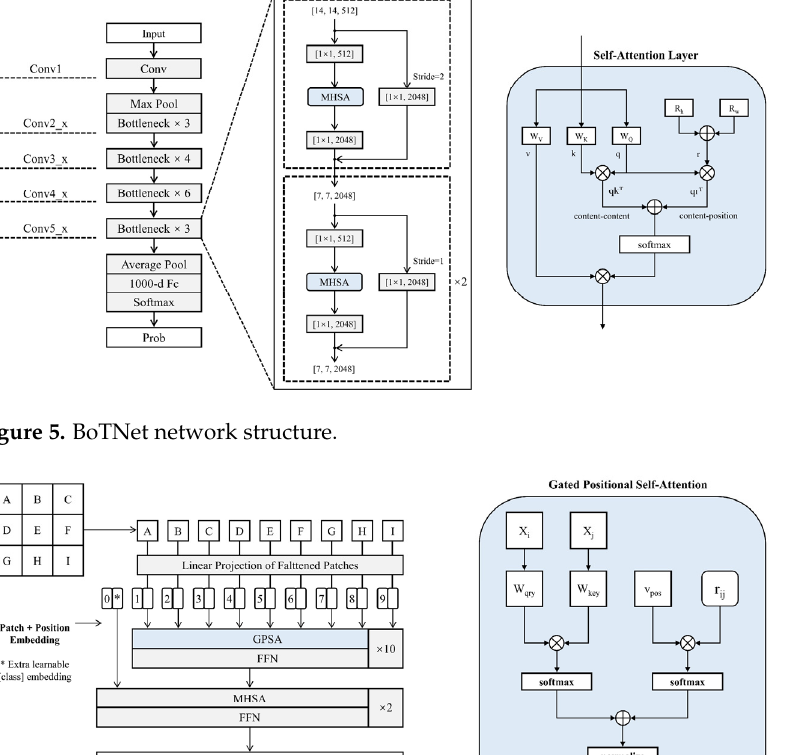
Figure 5. BoTNet network structure.